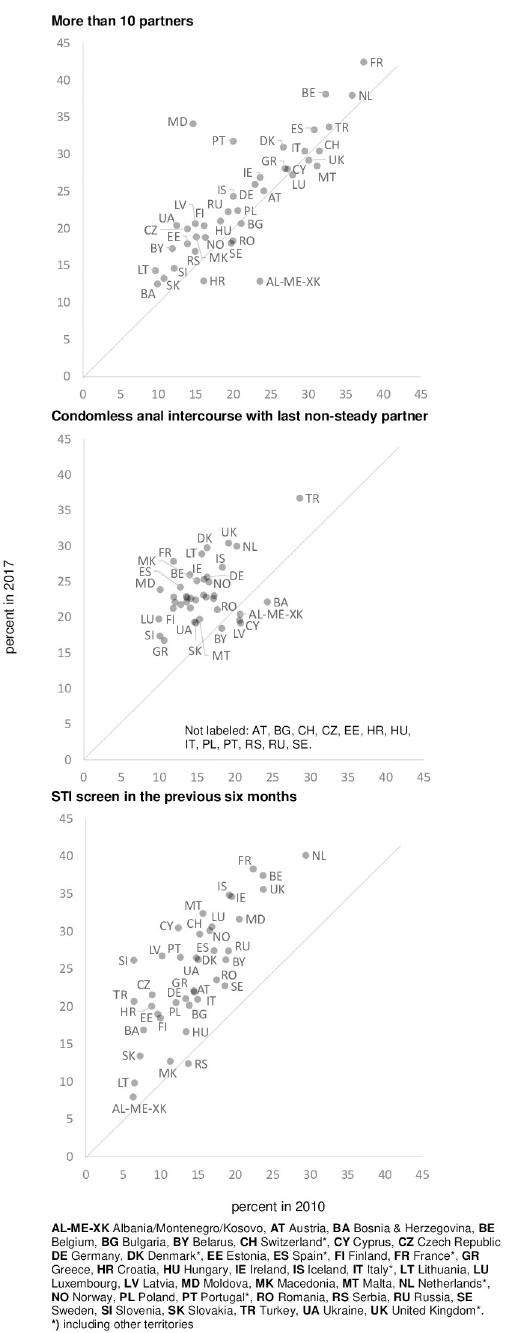
Fig 3. Explanatory variables. Panel of 3 country-level scatter plots (behaviour): More than 10 partners; Condomless anal intercourse with last non-steady partner; STI screen in the previous six months.